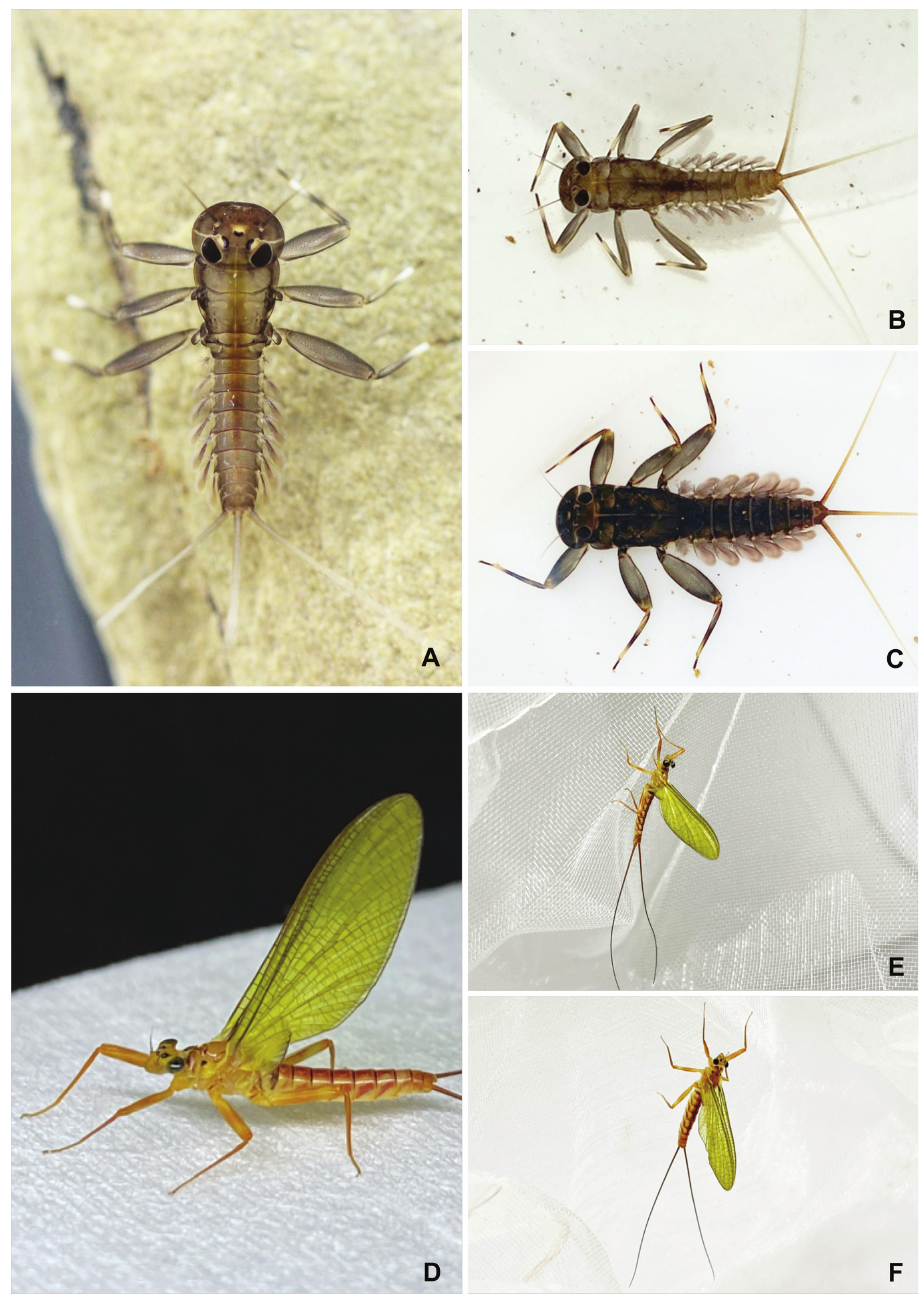
Figure 10. Paegniodes sapanensis sp. nov., habitus (live) A immature larva B male larva C female larva D closer view of female subimago E male subimago F female